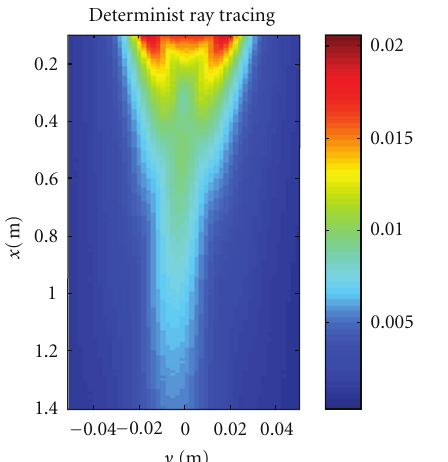
Figure 9: Acoustic beam propagation in inhomogeneous medium calculated by determinist ray tracing model (acoustic source position is at [ x = 0; − 0 . 02 < y < 0 . 02] coordinates).